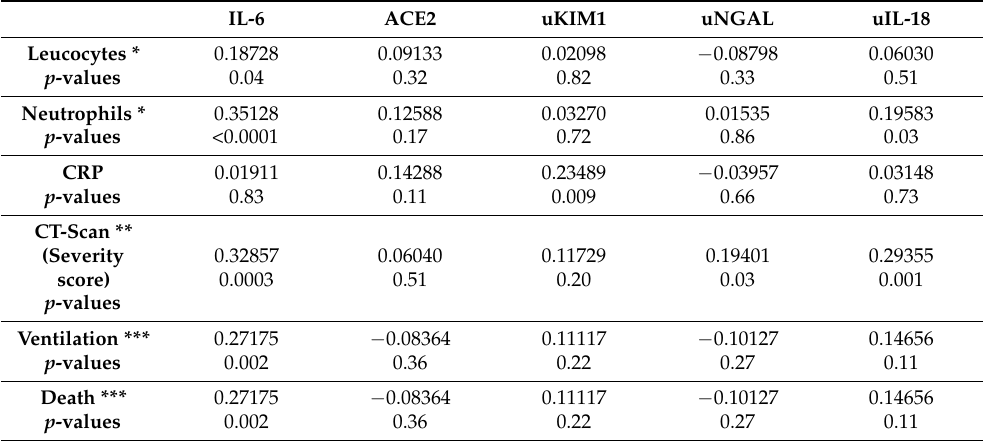
Table 4. Overall correlation for the biomarkers for the COVID-19 positive patients .